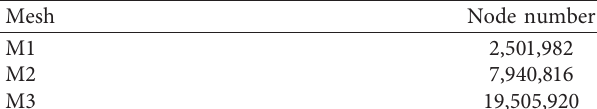
Figure 3: Mesh of the submerged jet domain. Table 1: Node number of the mesh used for GIS analysis.